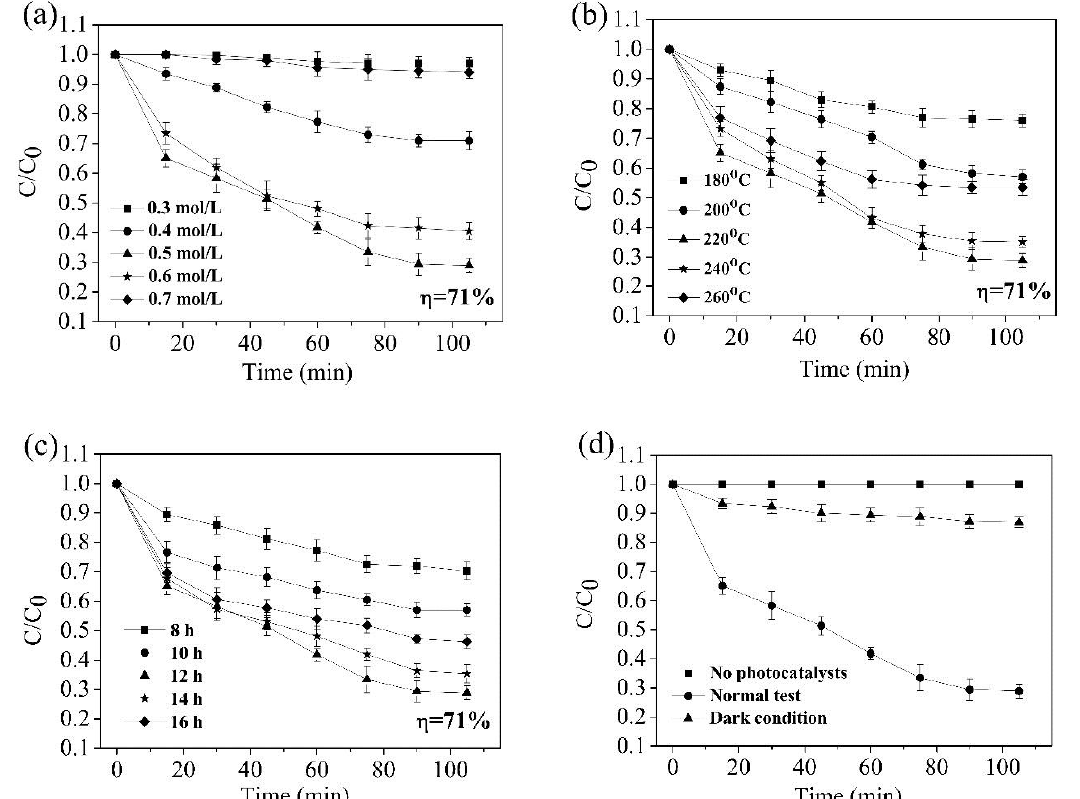
Figure 12. Variation of C/C 0 of methyl orange (MO) solution with photocatalytic time. ( a )